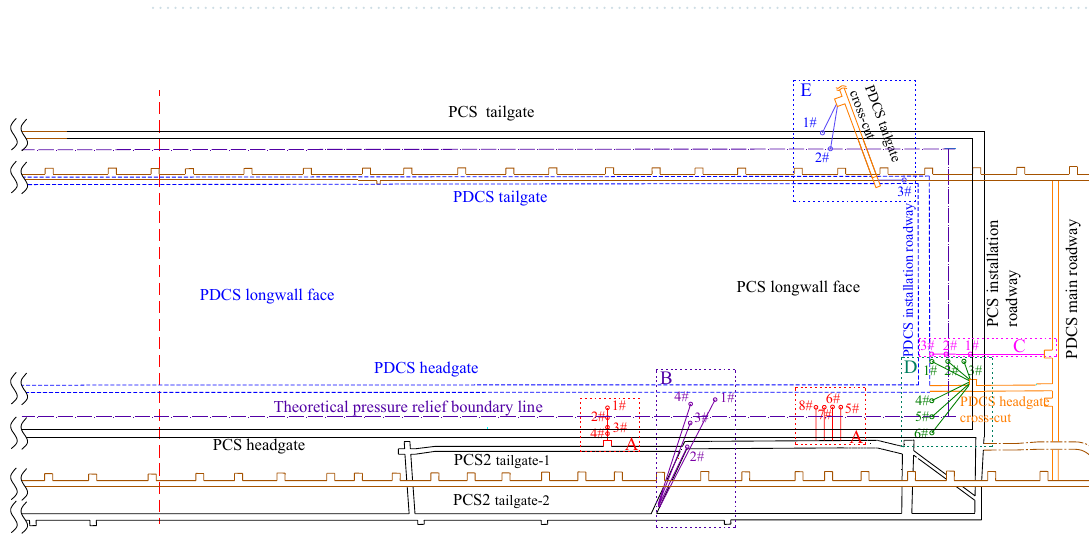
Table 2. Calculation parameters of permeability coefficient by RFP method.